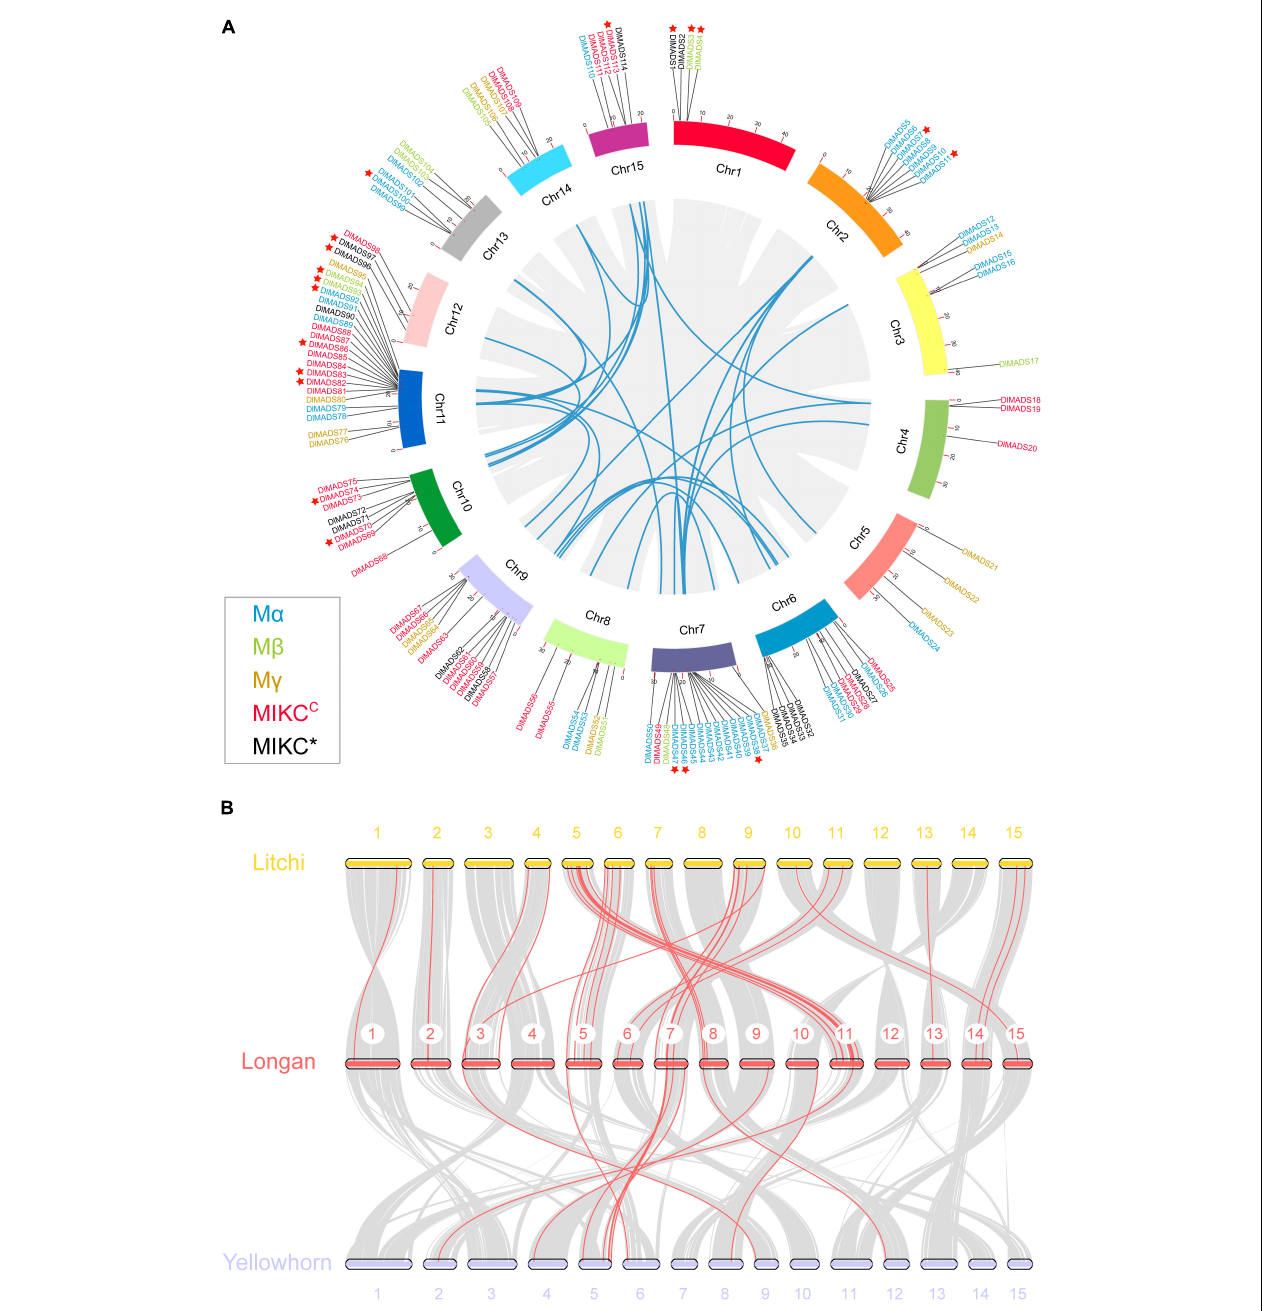
FIGURE 3 | Chromosomal location and synteny analysis of the MADS-box genes. (A) A total of 114 MADS-box genes are located in 15 chromosomes with different colors. Gene pairs of WGD or segmental duplication are linked using blue lines. Tandem duplication genes are marked by red stars. Gene labels of five types: M α , M β , M γ , MIKC* , and MIKC C are denoted by blue, green, yellow, red, and black, respectively. (B) Synteny relationship of type I MADS-box genes from longan, litchi, and yellowhorn genomes. Gray lines in the background indicate the collinear blocks within two genomes. Red lines highlight the syntenic type I MADS-box gene